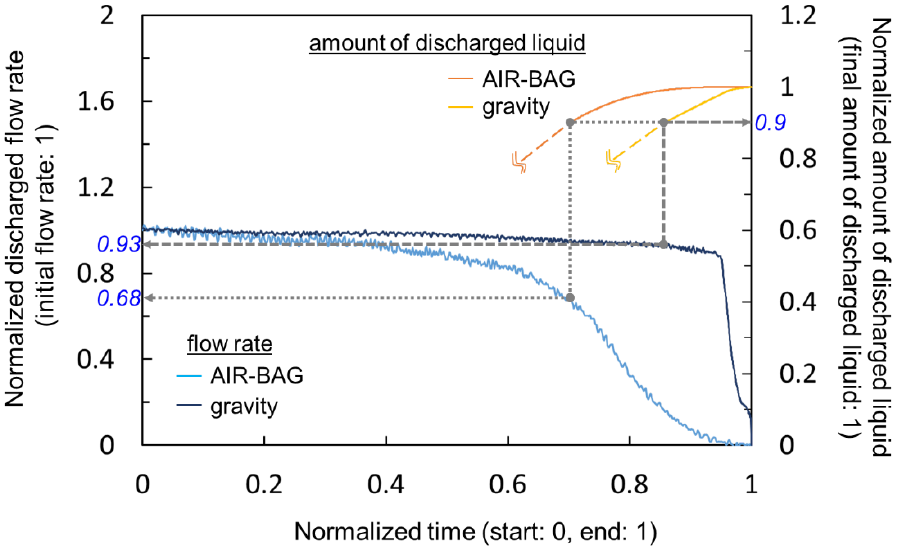
Figure 11. Comparison of the infusion flow rate stability between the prototype AIR-BAG and the existing gravity-driven method.